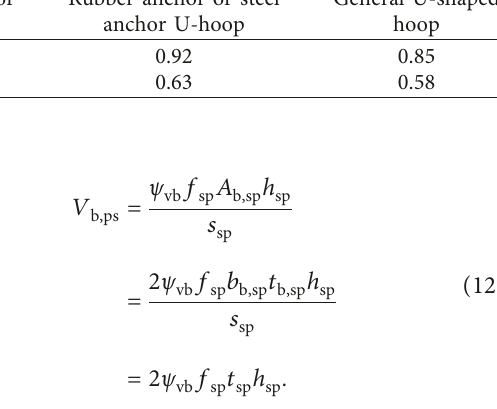
Make up of the hoop plate